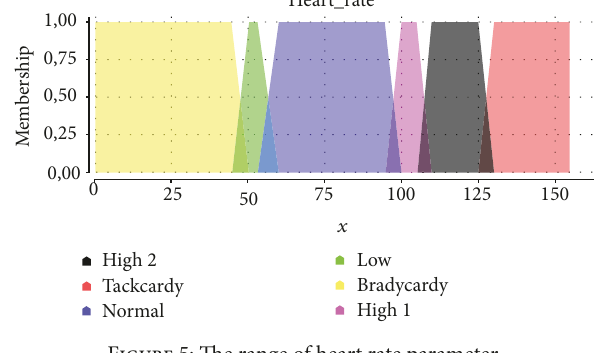
Figure 5: The range of heart rate parameter.